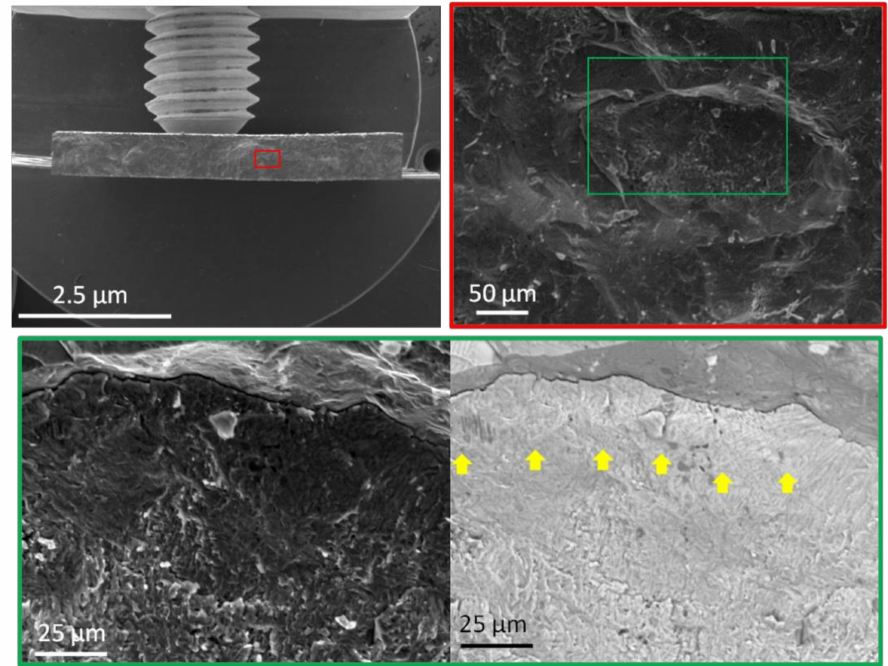
Figure 13. Fractography of titanium aluminide samples after heat